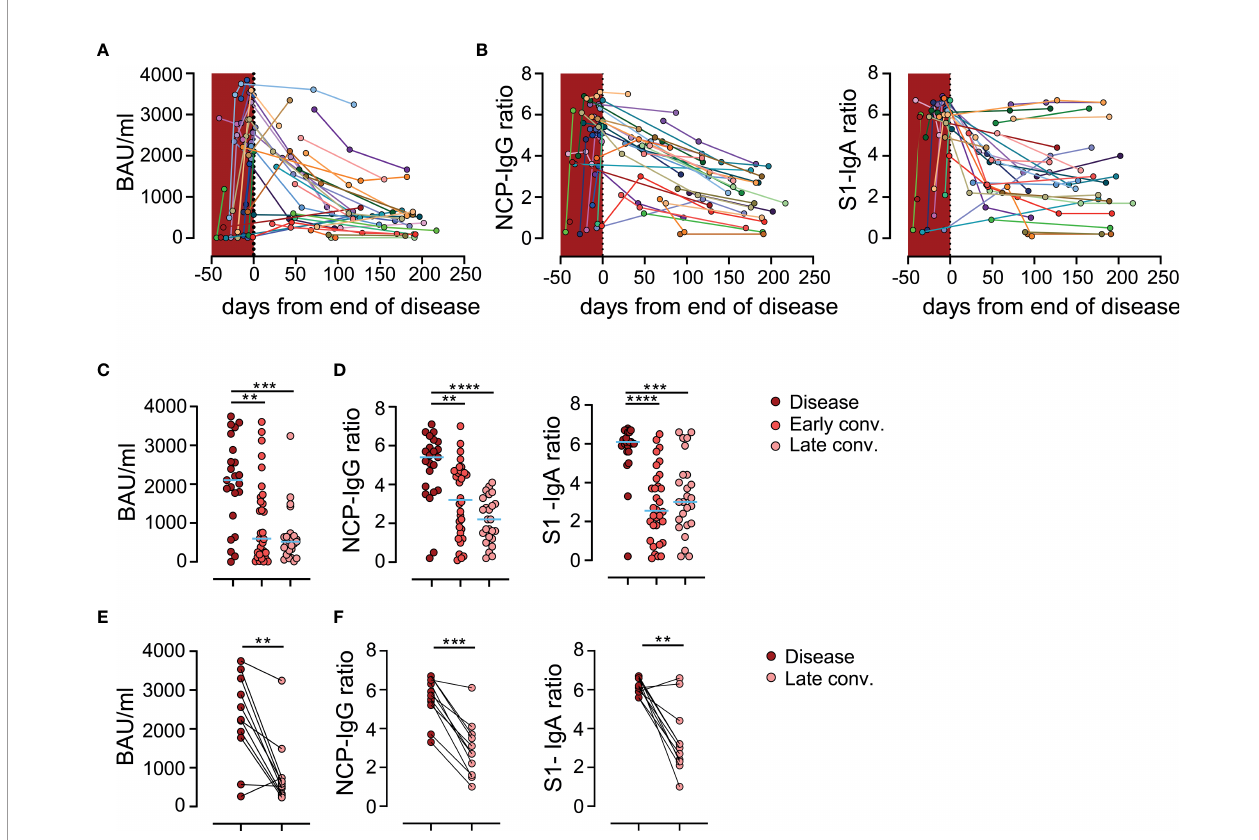
FIGURE 3 | Anti-SARS-CoV-2 antibodies are declining in sera of convalescing patients. (A) Anti-Spike IgG levels in patients over time. Each individually colored dot and connecting line represent one patient ( n =39 patients). Crimson shaded area represents the time during the disease. (B) Ratio of anti-nucleocapsid protein (NCP) IgG antibodies (left) and anti-Spike IgA (right) antibodies in patients over time. (C) Anti-Spike IgG levels in patients with disease, in early (early conv.) and late convalescence (late conv.). Each dot represents one biologically individual sample taken from one patient. N (disease)=23; n (early conv.)=32; n (late conv.)=25. (D) Ratio of anti-NCP IgG (left) and anti-Spike IgA (right) levels in patients. (E) Paired analysis of anti-Spike IgG levels in patients 3-7 months after the disease. Each connected dot represent one individual patient ( n =11). (F) Paired analysis of ratios of anti-NCP IgG (left) and anti-Spike IgA (right) levels in patients 3-7 months after the disease. Statistics: (C, D) Kruskal-Wallis multiple comparison test with Dunn ’ s post hoc correction. (E, F) Two-tailed Wilcoxon matched-pairs signed rank test. BAU, Binding Antibody Units; **p<0.01; ***p<0.001;